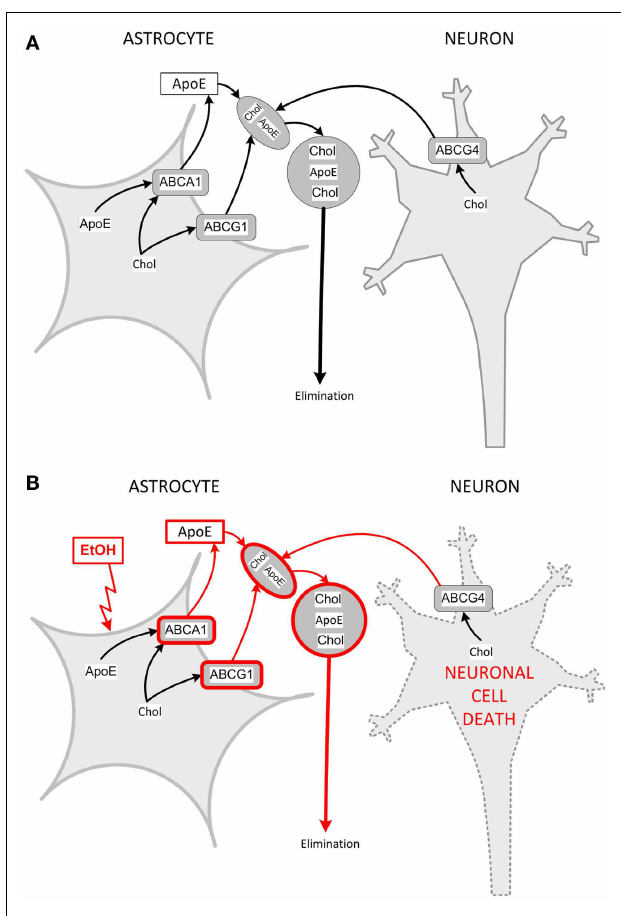
FIGURE 3 | Model for interactions of astrocytes and neurons in cholesterol clearance and dysregulation by ethanol . (A) Cholesterol is produced by both astrocytes and neurons. Astrocytes produce and release nascent, lipid-poor lipoproteins through the lipidation of apoE via the membrane-bound ABCA1. In the brain parenchyma, nascent lipoproteins stimulate cholesterol efflux through their interaction with ABCA1 and ABCG1 in astrocytes and ABCG4 in neurons. Lipoprotein-associated cholesterol exits the brain through the cerebrospinal fluid. (B) Ethanol upregulates ABCA1 and ABCG1 in astrocytes, and increases the formation of astrocyte lipoproteins, which extract more cholesterol from astrocytes and neurons (pathways upregulated by ethanol are in red). Neurons are sensitive to changes in cholesterol content and, upon protracted induction of cholesterol efflux, decrease their cholesterol content and undergo cell death. Chol, cholesterol.